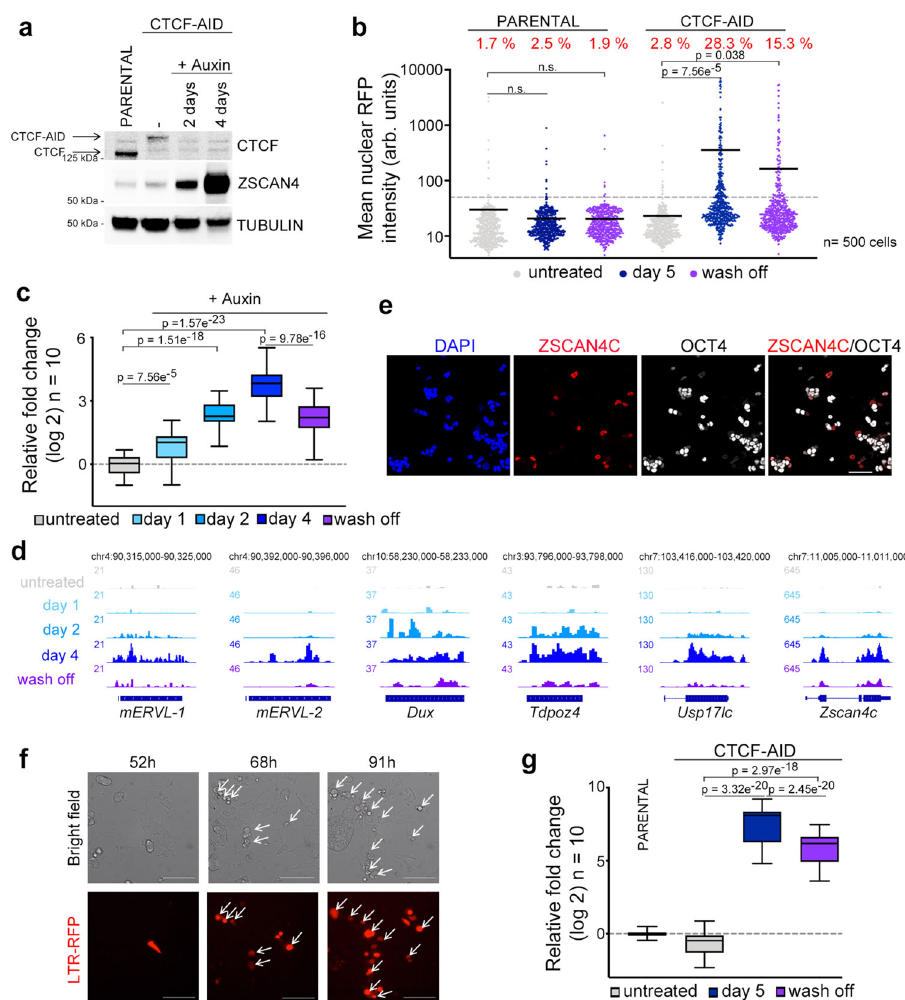
Fig. 3 Spontaneous 2C-like conversion in CTCF-depleted ESC. a Western blot analysis performed in parental ESC and ESC CTCF-AID treated with auxin for the indicated times. Tubulin levels are shown as a loading control. b HTI quanti fi cation of RFP + cells in untreated or auxin-treated for fi ve days LTR-RFP reporter parental ESC and ESC CTCF-AID . RFP + cells two days after a wash-off following three days of auxin treatment were also quanti fi ed. Center lines indicate mean values. Percentages of RFP + cells above the threshold are indicated. n = 500; p -values are shown from two-tailed unpaired t -tests. n.s. = non-signi fi cant. c Box and whisker plot showing the relative fold change (log2) expression of ten 2C-associated genes/repeats (DUX, ZSCAN4, ZFP352, TCSTV3, SP110, TDPOZ1, DUB1, EIF1ad8, PRAMEL7 and MERVLs) in ESC CTCF-AID treated with auxin for the indicated times. Untreated and wash off ESC CTCF-AID were also included. Data was obtained from RNAseq datasets 27 . d Genome browser tracks showing RNAseq RPKM read count at the indicated genes in the same samples as in c . e Immuno fl uorescence analysis of ZSCAN4 and OCT4 in ESC CTCF-AID treated with auxin for 4 days. DAPI was used to visualize nuclei. Scale bar, 100 μ m. f Representative bright fi eld images (upper panels) from a time lapse experiment performed in auxin-treated LTR-RFP reporter ESC CTCF-AID . RFP + cells are shown as they convert over time (lower panels). Time since the addition of auxin is indicated. White arrows indicate 2C-like converted cells undergoing cell death. Scale bars, 100 μ m. g Box and whisker plot showing the relative fold change (log2) expression of ten 2C-associated genes (same as in c ) in LTR-RFP reporter ESC CTCF-AID untreated or treated with auxin for four days and further incubated with auxin or washed-off for additional 18 h (a total of fi ve days) and sorted based on RFP expression. GAPDH expression was used to normalize. For box plots ( c , g ), center line indicates the median, box extends from the 25 th to 75 th percentiles and whiskers show Min to Max values. p values are shown from two- tailed paired t -tests. In a , b , e – g , one representative experiment is shown but three ( a , b ) and two ( e – g ) independent experiments were